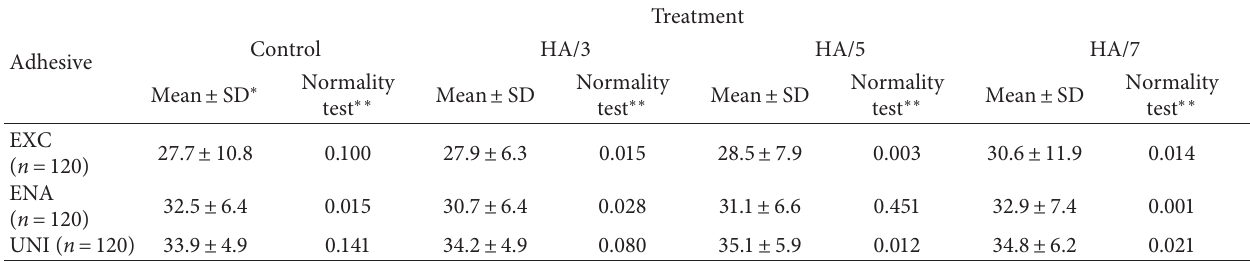
Table 2: Descriptive statistics for microtensile strength of different groups with different dentin treatment.